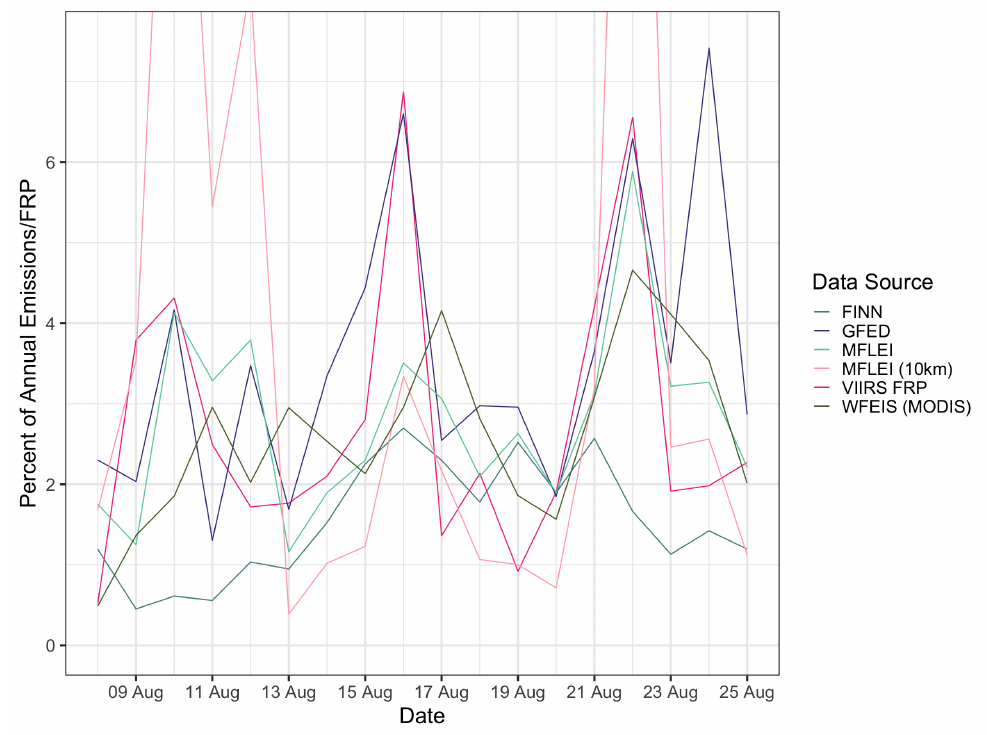
Figure 5. The percentage of annual FRP from VIIRS emitted per day with the percentage of annual PM 2.5 emitted per day from all fire emissions inventories for 9–25 August 2013. This period contains all of the frequently occurring influential points. The MFLEI (10 km) points that exceed the y-axis correspond to 13.57%, 8.19%, and 17.07%, in chronological order. VIIRS FRP shows peaks in fire activity on 10 August, 16 August, and 22 August. GFED captures these maxima closest, explaining VIIRS data aside from those three